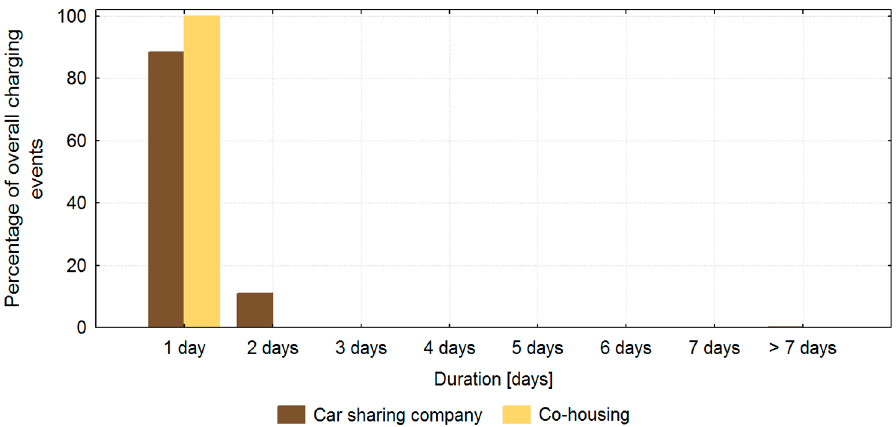
Figure 5. Charging behavior—the duration of charging event in days.